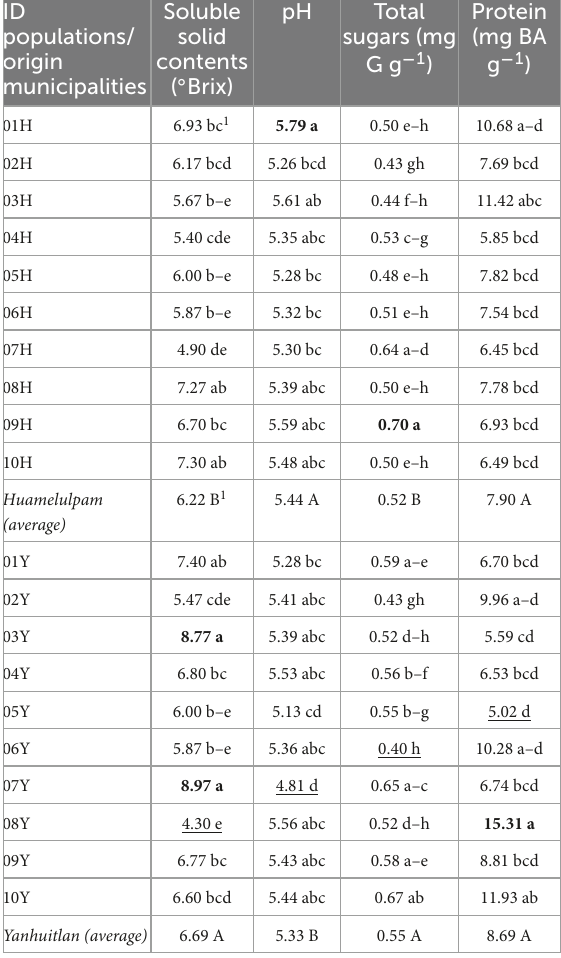
TABLE 3 Variation in total polyphenol and flavonoid contents and antioxidant activity between C. ficifolia populations from two municipalities of Oaxaca,